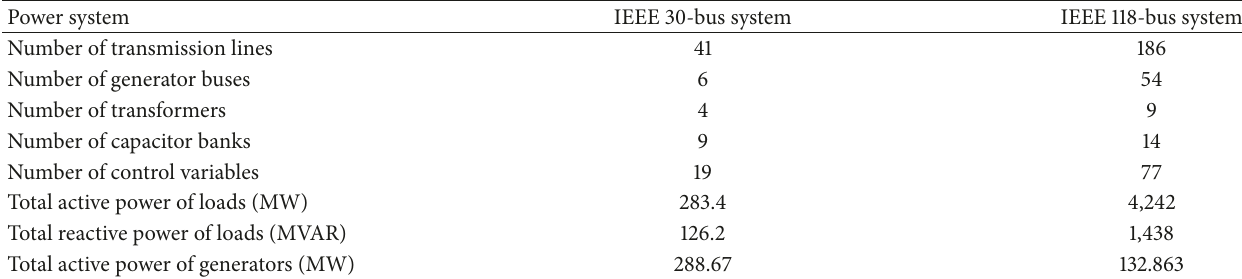
Table 11: The information of IEEE 30-bus system and IEEE 118-bus system.